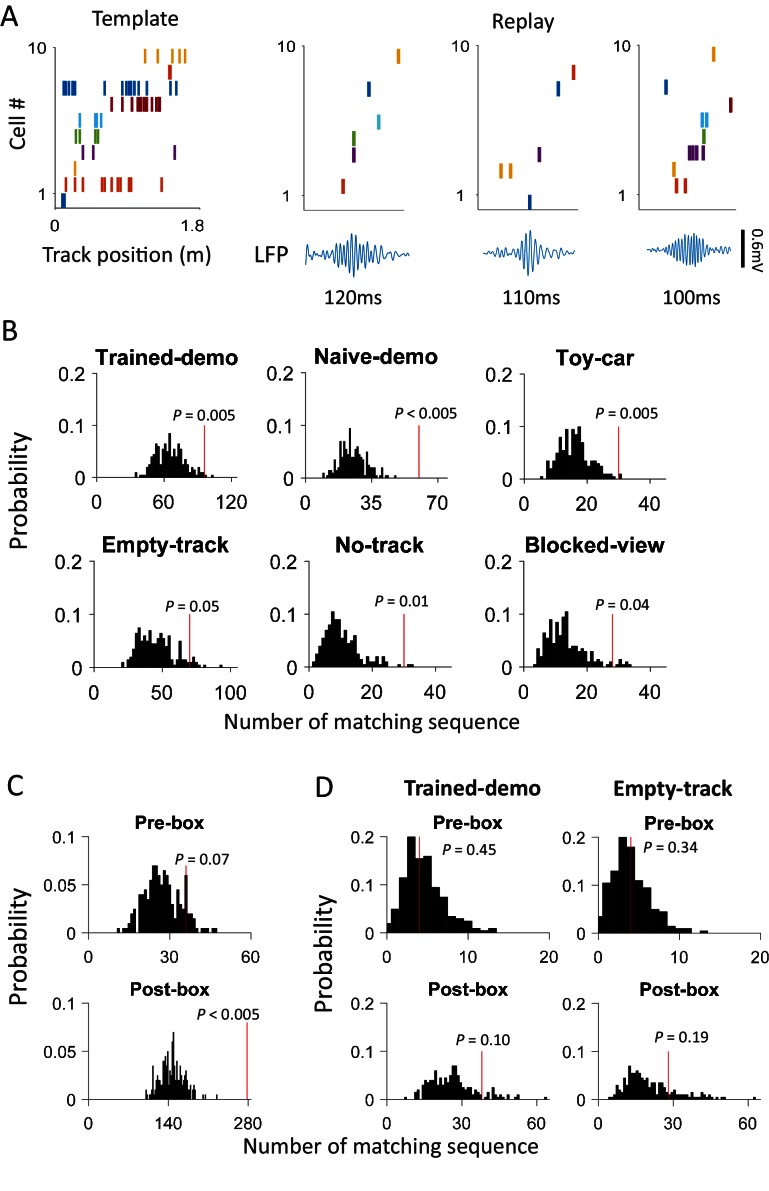
Ripple-associated replay occurred in box sessions, but was insensitive to the presence of a demonstrator on the track.(A) Example replay events in a Post-box session. Left: a template firing sequence made of 10 cells during a lap running event on a trajectory, plotted similarly as in Figure 4A. Right: 3 examples of replay events, each plotted with the spike raster of the same 10 cells (top) and the CA1 LFP (bottom; filtered through the ripple band of 100–250 Hz). Each tick is a spike. Note the sequential firing of the cells in each replay example, similarly as in the template. (B) Number of replay events (red line) relative to the distribution of randomly-generated number of replays (black histogram) under each box condition. P: significance p-value. (C) Same as B, but for Pre-box and Post-box sessions with all box conditions combined. (B) Same as B, but for the Pre-box and Post-box session on the very first day under the Trained-demo and Empty-track conditions.